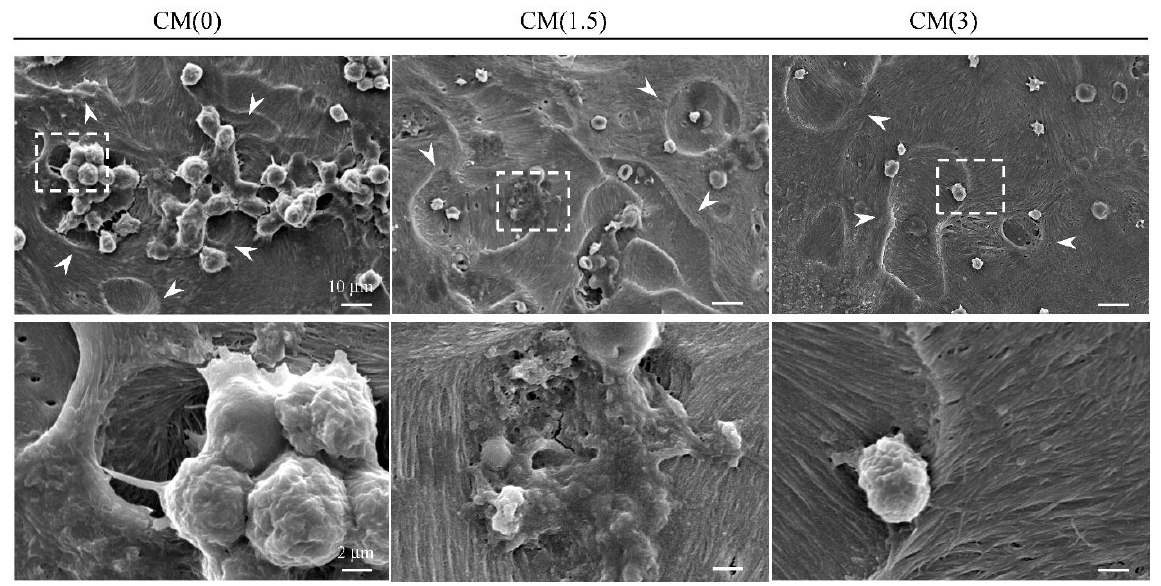
Figure 10. In vitro osteoclast-mediated bone resorption assay. mBMSCs were treated with osteoclastic (on the ZOL/β-TCP disc) conditioned medium on bone slice (mice calvaria) for 5 days. The surface of the bone slice was observed with SEM. The bottom panel shows magnification images of the dotted rectangle boxes in upper panel. Scale bars; 10 μm (upper panel), 2 μm (bottom panel), pit area; white arrow heads.